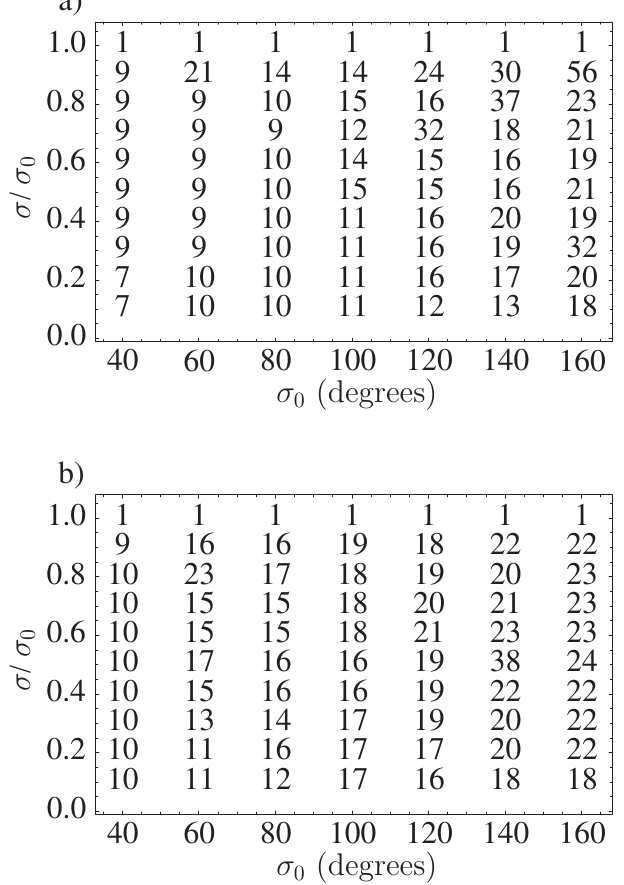
FIG. 7. Number of total hybrid IM iterations needed for case 0 using tol (cid:2) 10 (cid:1) 6 fractional error tolerance case 1 matched with 10 (cid:1) 4 fractional envelope solutions and root found " j accuracy from specified values for (a) solenoidal and (b) FODO ( (cid:7) (cid:2) 1 = 2 ) quadrupole lattices. The same system parame- ters and presentation format are employed as in Fig.